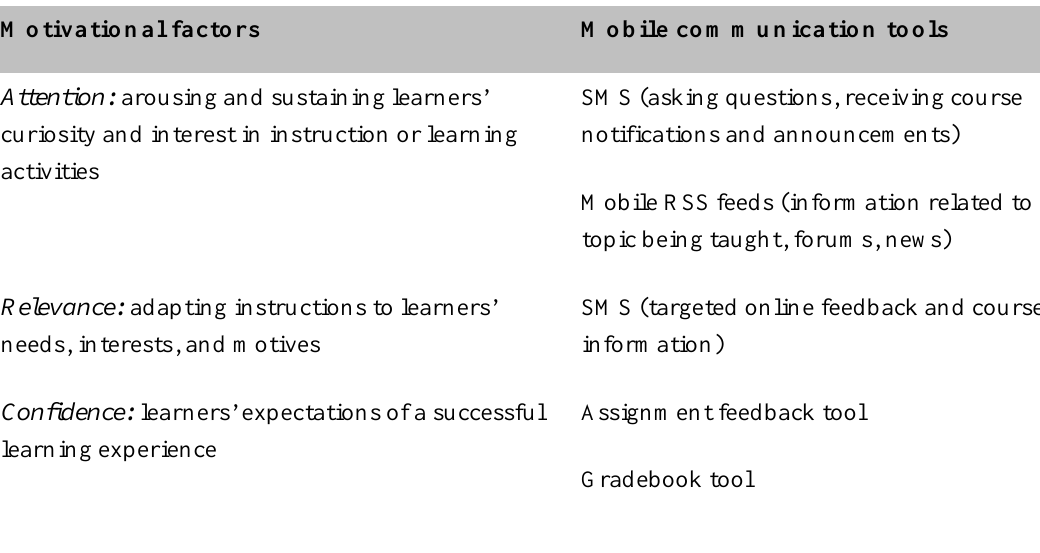
A Mobile Communication Tools Framework Motivational